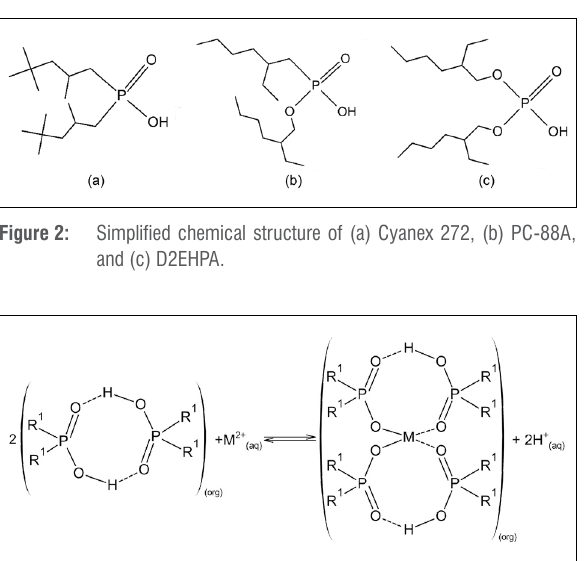
Figure 3. 33 The hydrogen on the hydroxyl group hydrogen-bonds with the